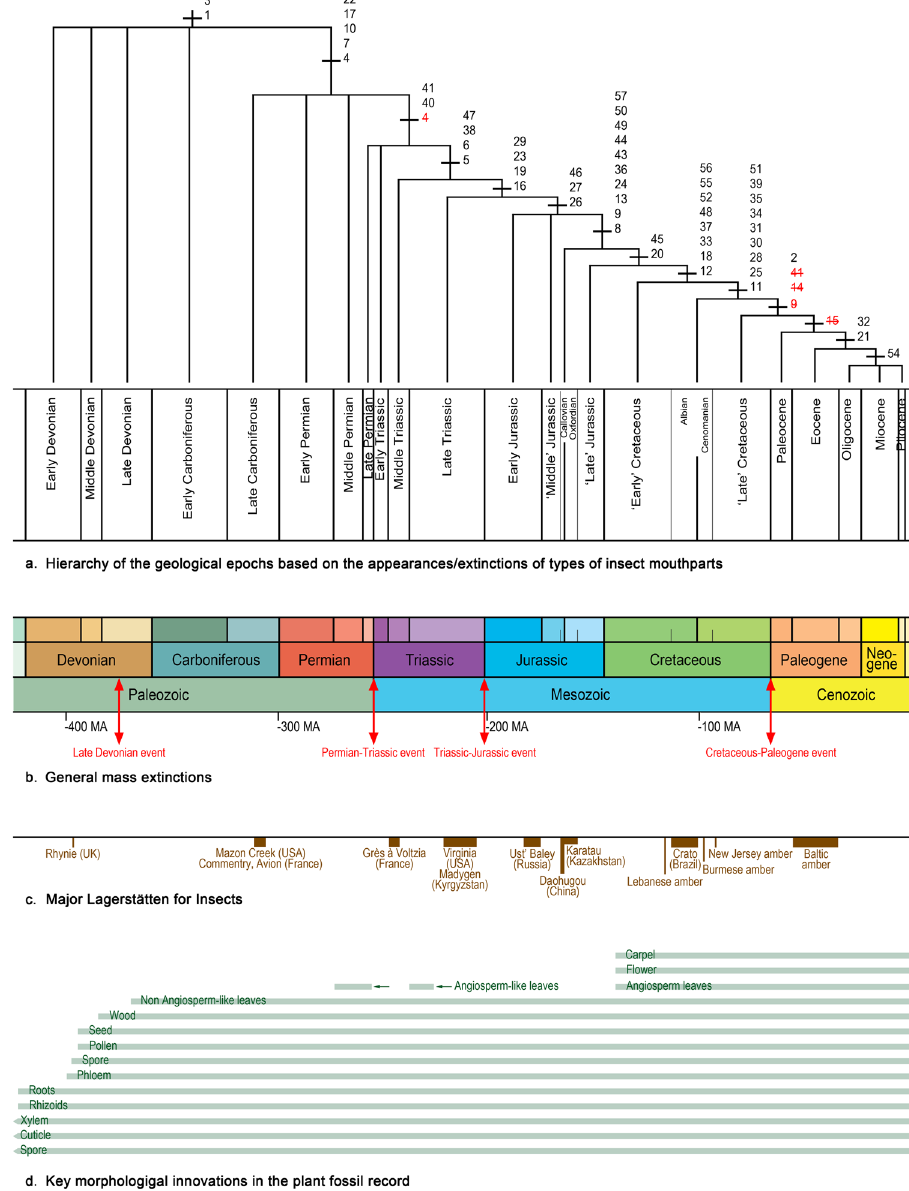
Figure 2. Results ( a ) Hierarchy of the geological epochs based on the appearances/extinctions of types of insect mouthparts through time using ‘Wagner Parsimony Analysis Applied to Palaeosynecology using Morphology’ 18,21 ; numbers are those assigned to the mouthparts types supporting the hierarchy, in black first records, in red and strikethrough extinctions. ( b ) Dates of main mass extinctions, recorded for marine organisms, time scale based on currently accepted geological epochs 22 plus two ‘artificial’ ones: ‘Callovian- Oxfordian’ (for a Middle-Late Jurassic) and ‘Albian-Cenomanian’. ( c ) Positions and approximate durations of major insect Lagerstätten. ( d ) Key morphological innovations in plant fossil record, partly based on 53 . ( d ) is not covered by the CC BY licence. [EVOLUTION OF PLANTS 2E by K. J. Willis & J. C. McElwain (2013): Figure 9.4 (p.304)], all rights reserved, used with permission from Oxford University Press. Copyright P.N. for other